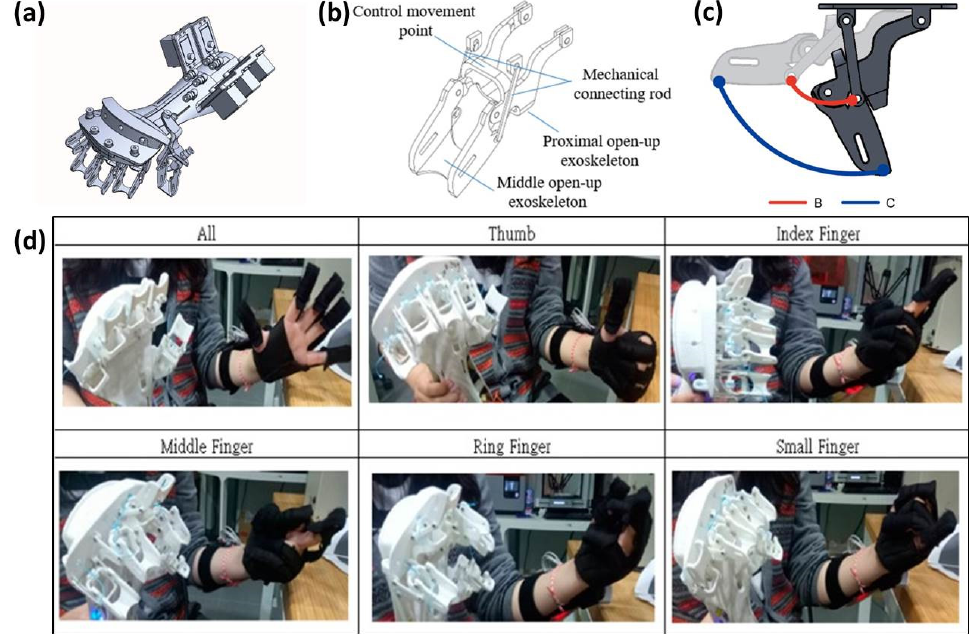
Figure 7. Design and development of a wearable exoskeleton system for stroke rehabilitation. ( a ) and ( b ) are schematics of the exoskeleton; ( c ) schematic of simulated finger joint movement arc; ( d ) actual movements of each finger joint [93].